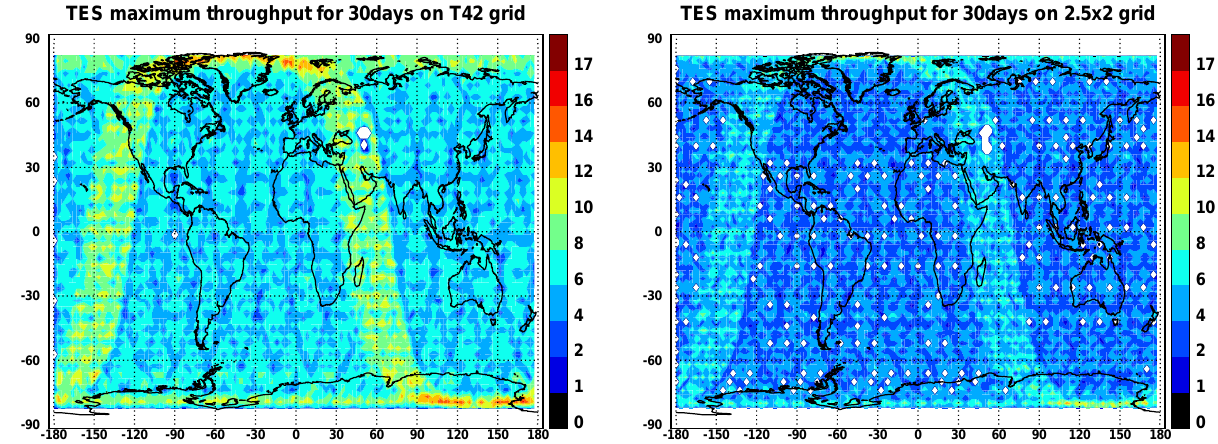
Fig. 2. The distribution of the maximum throughput of a nadir sun-synchronous sampling binned to the ECHAM5-MOZ and GISS-PUCCINI model grids of T42 and 2.5 × 2 respectively, in a 30-day